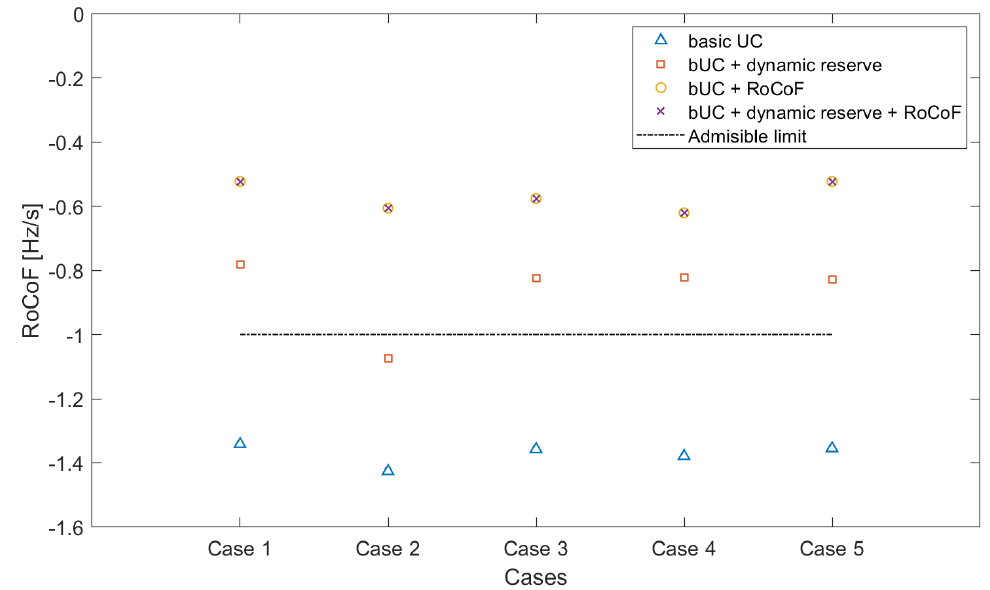
Figure 10. Worst RoCoF obtained with each constraint in the five